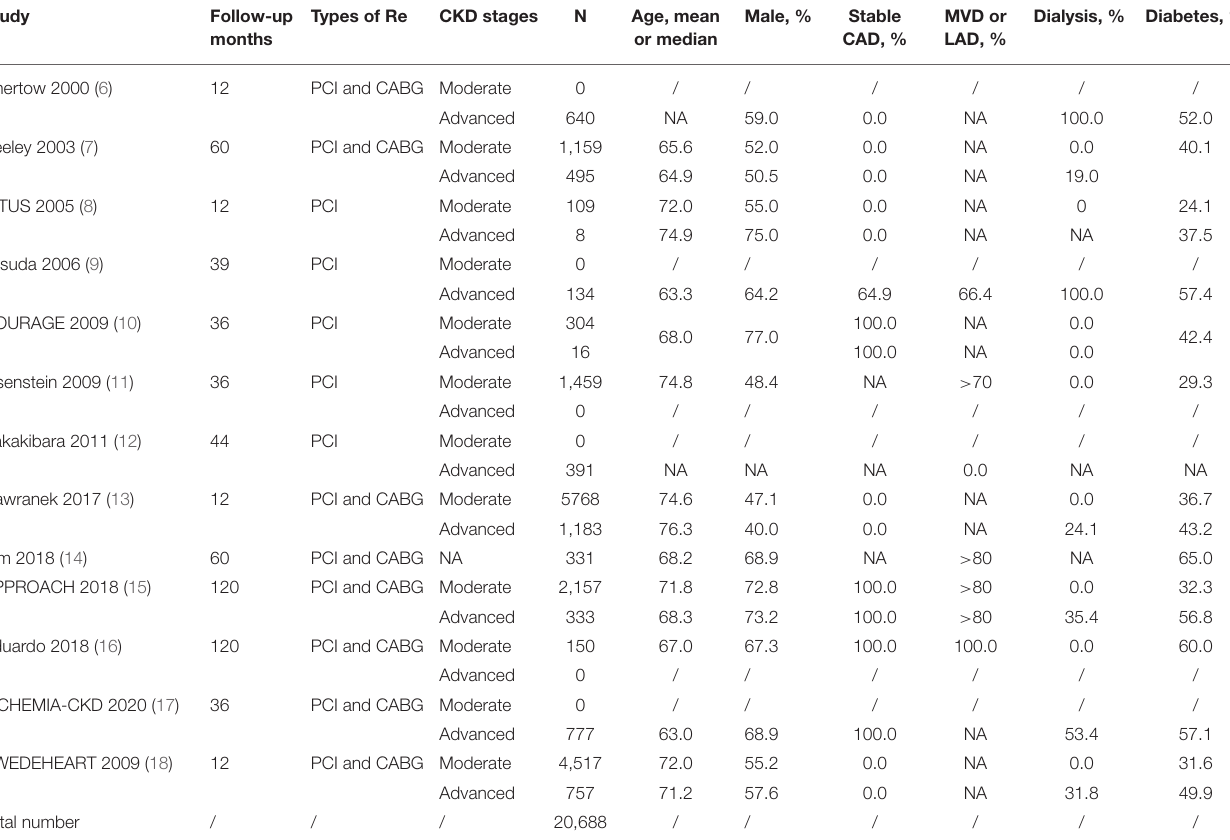
TABLE 1 | Baseline characteristics of included